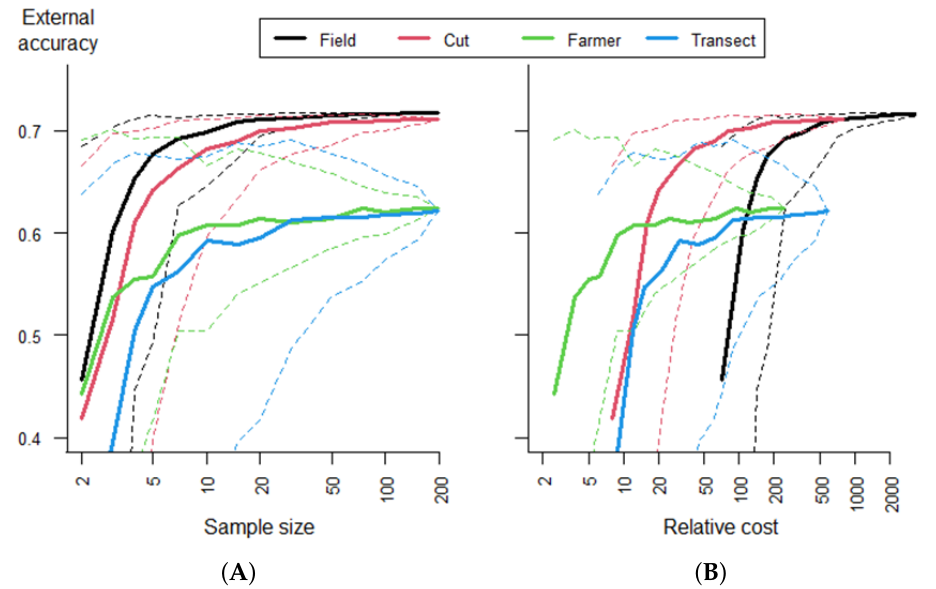
Figure 4. Maize yield prediction external accuracy for single-variable linear models (LR-1) using GNDVI-maximum as the predictor variable for four groupings of the eight field-based yield estima- tion techniques as a function of ( A ) sample size and ( B ) cost. Cost is expressed as a relative measure of effort where farmer estimates cost 1 unit and a full-field harvest is 35.6-times that amount of effort. Both sample size and relative cost are on a log-scale. Computed with Monte Carlo simulation (n = 200); the thick line is the median, and the dashed lines are the 0.05 and 0.95 quantiles. The values for the field estimation techniques were computed as the mean of their respective more disaggregated measures (see Table